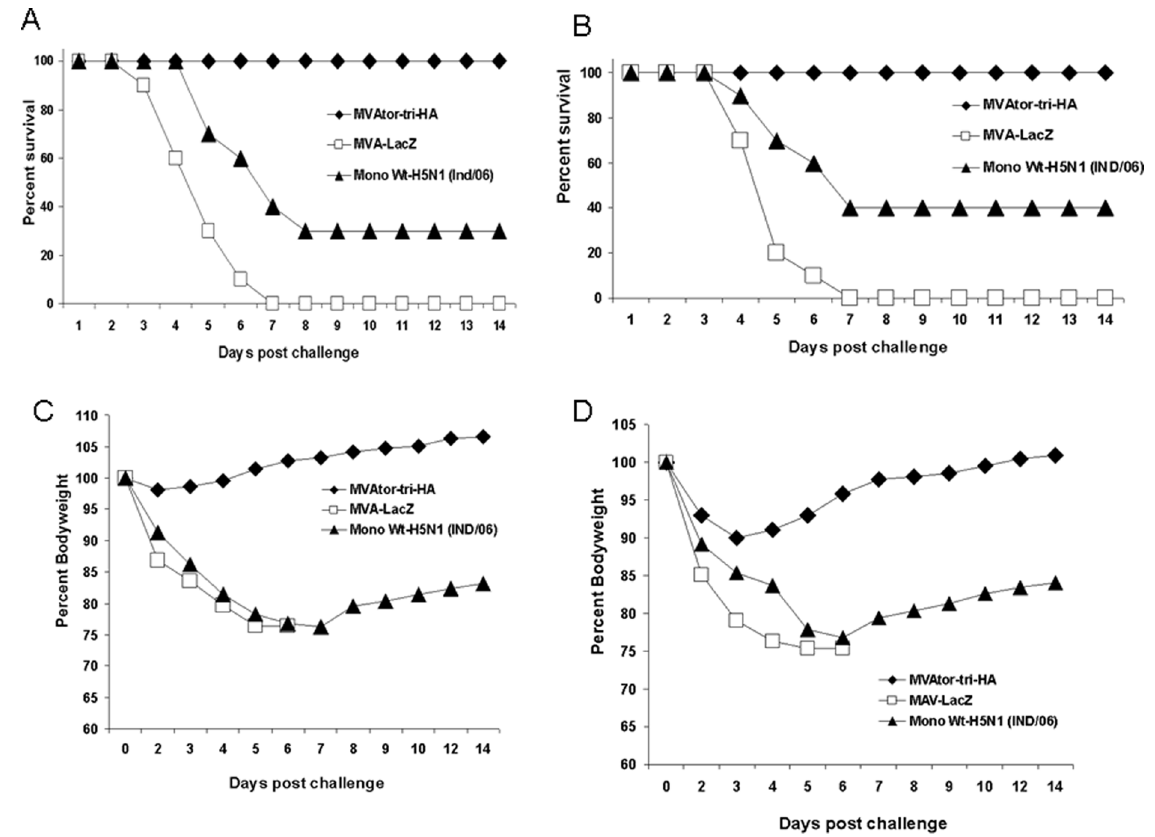
Figure 4. Protection of mice from lethal H5N1 virus challenge. Each group of mice was immunized i.m. two times on days 0 and 28 with MVAtor-tri-HA or MVAtor-mono-HA (A/Vietnam/1203/04) or MVA-LacZ vector. The reference control group was immunized s.c. with adjuvanted inactive H5N1 viral vaccine (A/Indonesia/CDC669/06). Three weeks after the second vaccination, mice were intranasally infected with 10 MLD 50 of a clade 1.0 (RG-A/Vietnam/1203/04) or clade 7.0 (RG-A/chicken/Shanxi/2/2006) H5N1 strain. Mice were monitored for survival throughout a 14-day observation period after clade 1.0 (A) or clade 7.0 (B) H5N1 viral challenge. The results are expressed in percent survival. Mice were monitored for weight loss throughout a 14-day observation period after clade 1.0 (C) or clade 7.0 (D) challenge. The results are expressed in terms of percent body weight compared to the start of the viral challenge.